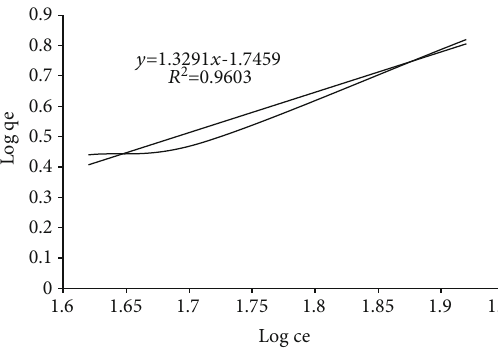
Figure 6: Freundlich isotherm for RR2 adsorption on GWAC at ( pH = 7 , contacttime = 50 min , dye concentration = 300 mg/L